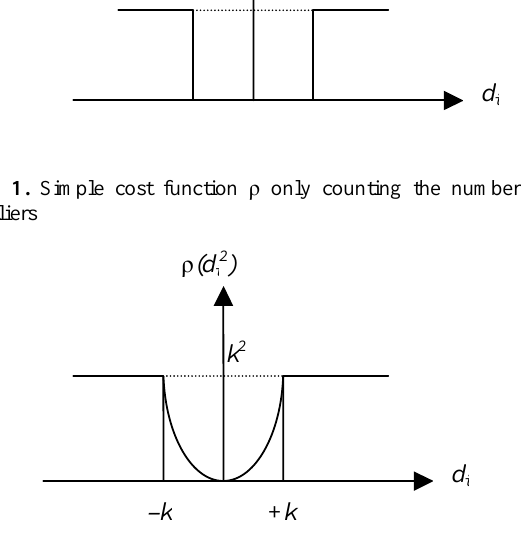
Fig 2 . Cost function: for small errors it leads to a least-squares solution and large values have a limited influence on the